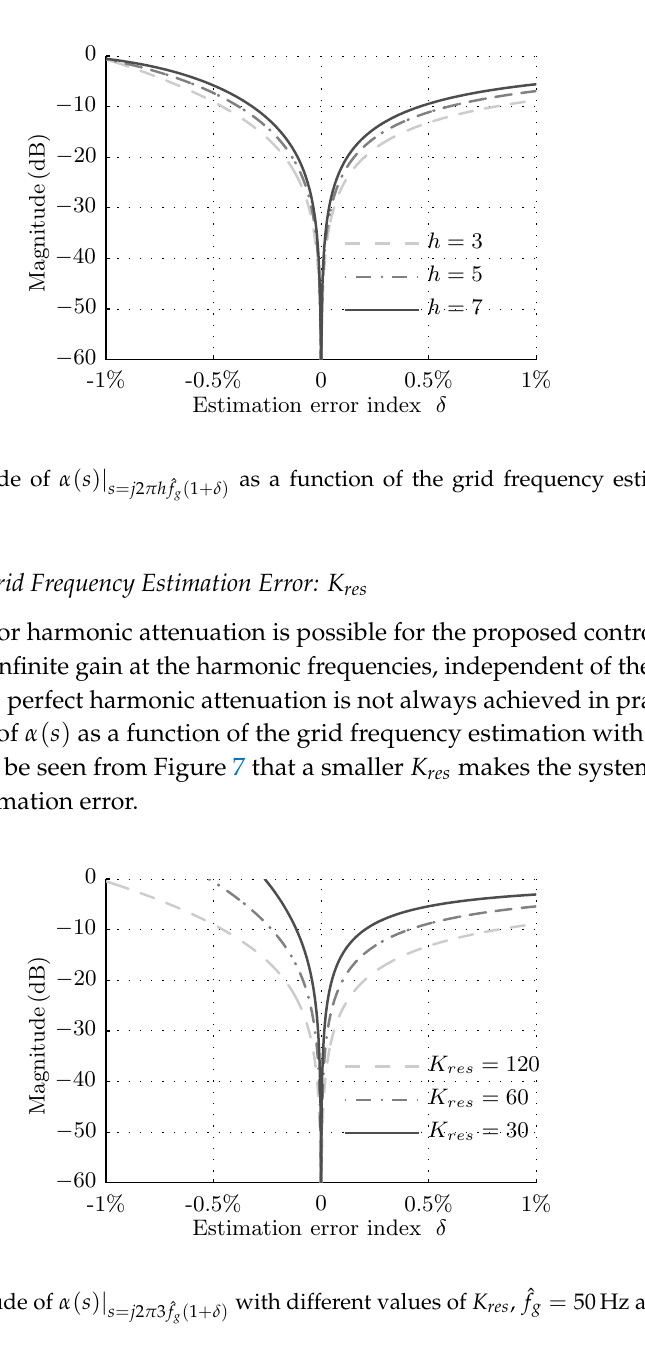
Figure 7. Magnitude of α ( s ) | with different values of K res , ˆ f g = 50Hz and N h = { 3 } s = j 2 π 3 ˆ f g ( 1 + δ )